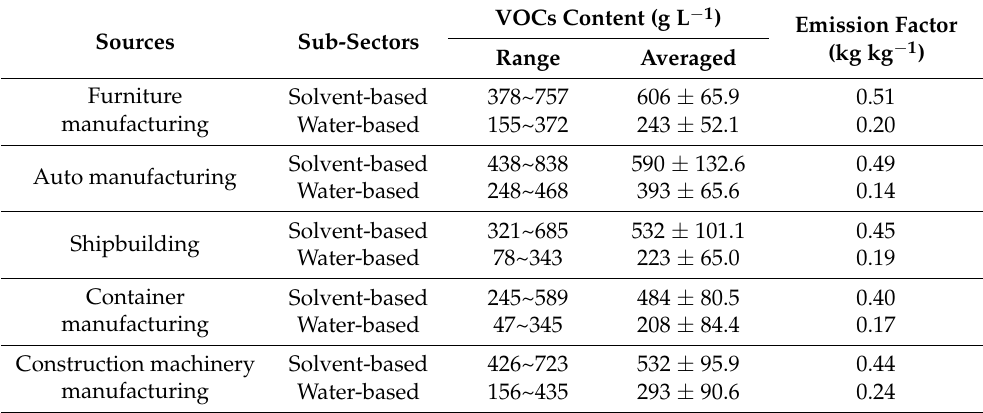
Table 2. The measured VOCs content and the localized uncontrolled VOCs emission factors for different kinds of industrial coating